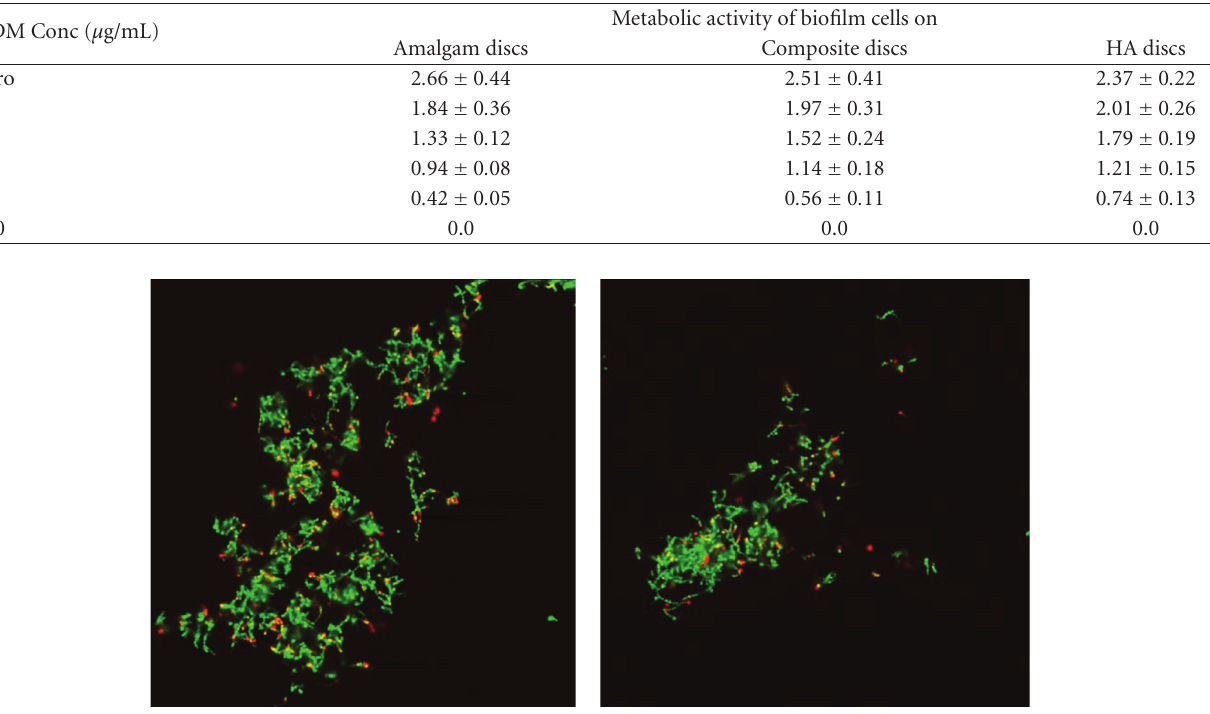
Figure 4: Confocal microscopic analysis of S. gordonii biofilm stained with Live/Dead Bac